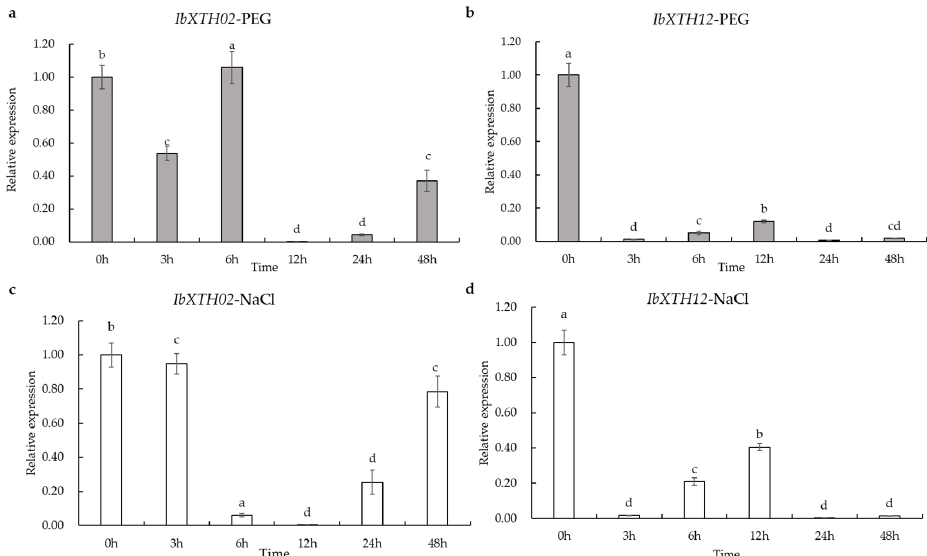
Figure 9. Expression profiles of IbXTH02 and IbXTH12 in response to PEG6000 and NaCl treatment ( a ) Expression patterns of IbXTH02 in response to PEG-induced drought stress in FR of Xushu 18 were examined by a qPCR assay. ( b ) Expression patterns of IbXTH12 in response to PEG-induced drought stress in FR of Xushu18 were examined by a qPCR assay. ( c ) Expression patterns of IbXTH02 in response to NaCl stress in FR of Xushu18 were examined by a qPCR assay. ( d ) Expression patterns of IbXTH12 in response to NaCl stress in FR of ‘Xushu 18’ were examined by a qPCR assay. The fibrous root was obtained at 0, 3, 6, 12, 24, and 48 h after PEG6000 and NaCl stress. The mean fold changes of each gene between treated and control fibrous root in Xushu18 were used to calculate its relative expression levels. Data are means ± SD of three biological replicates. Means denoted by the same letter do not significantly differ at p < 0.05, as determined by Duncan’s multiple range